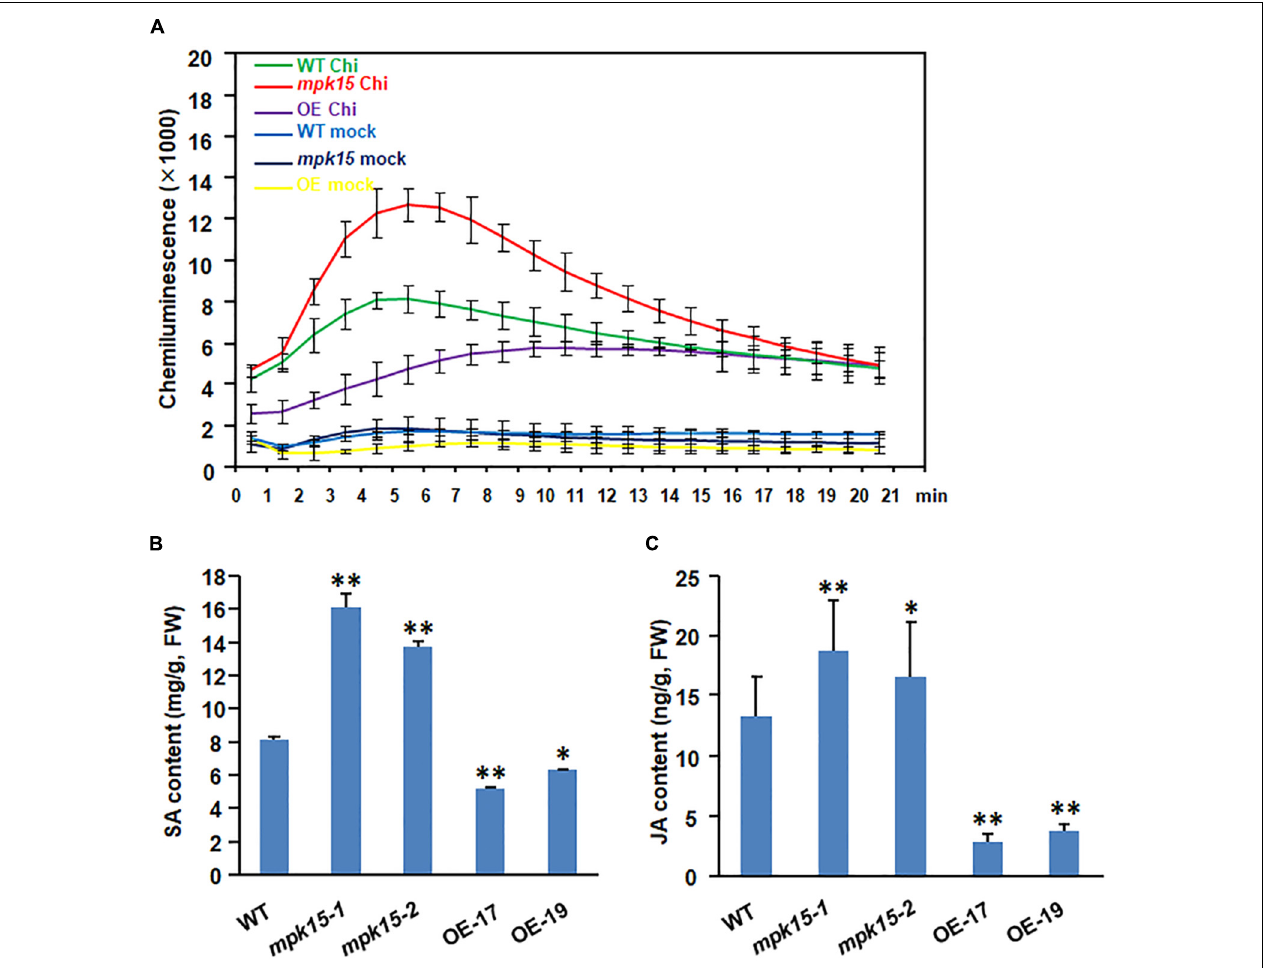
FIGURE 5 | Increase in the ROS accumulation and disease-related hormone levels in the mpk15 mutants. (A) ROS accumulation dynamics in the WT, mpk15 mutant, and OsMPK15-OE plants at 90 dps after treatment of chitin and water (mock) treatment served as a control. Error bars are computed from three replicates ( n = 3). (B,C) The 30-day-old seedling leaf samples of the WT, mpk15 mutant and OsMPK15-OE lines under normal conditions were used for analyses of SA and JA contents. FW: fresh weight. Data presented are the mean ± SD from three independent experiments. ∗ P ≤ 0.05; ∗∗ P ≤ 0.01 (Student’s t